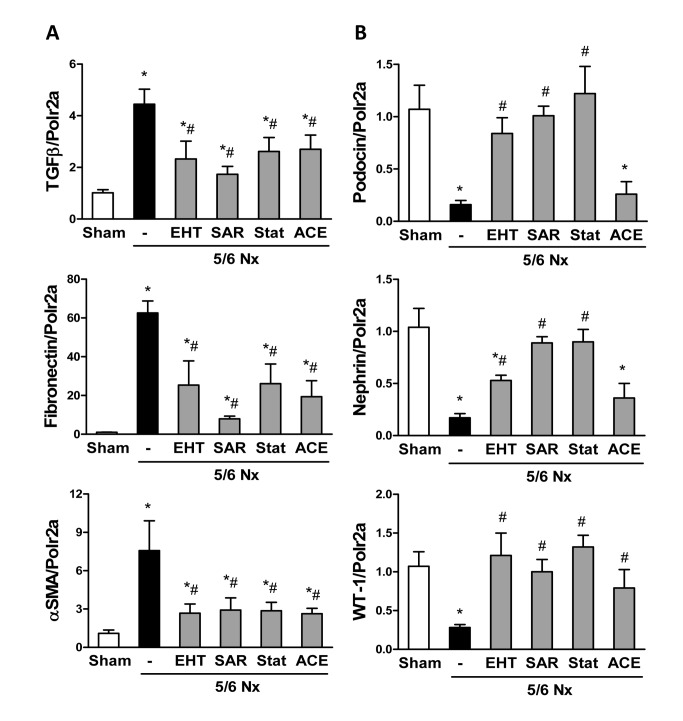
GTPase inhibition prevents 5/6Nx-induced renal fibrosis.RT-PCR analysis of renal TGFβ, fibronectin and smooth muscle α-actin (α -SMA) expression (A), and expression of podocyte specific markers podocin, nephrin and WT-1 (B) detected in renal cortex homogenates. Polymerase 2a (Polr2a) served as housekeeping gene. Data are expressed as mean ± SEM from four mice of each group. *P<0.05 vs. corresponding sham control; # P<0.05 vs. 5/6Nx control.